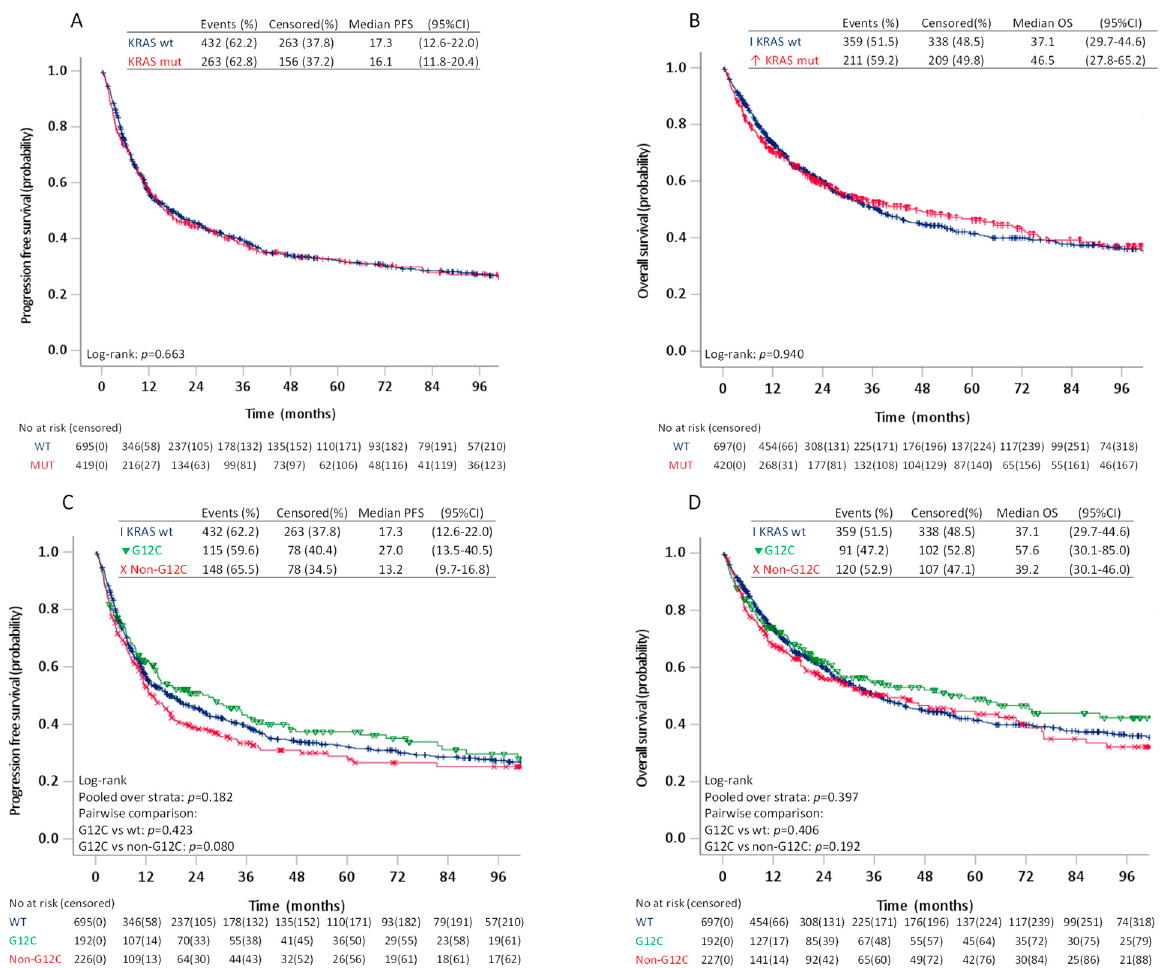
Figure 3. Progression free survival and overall survival in patients stage I–IV with KRAS wild type and KRAS mutated tumours ( A , B ) and patients with KRAS wild type, KRAS G12C, and KRAS non-G12C ( C , D ).